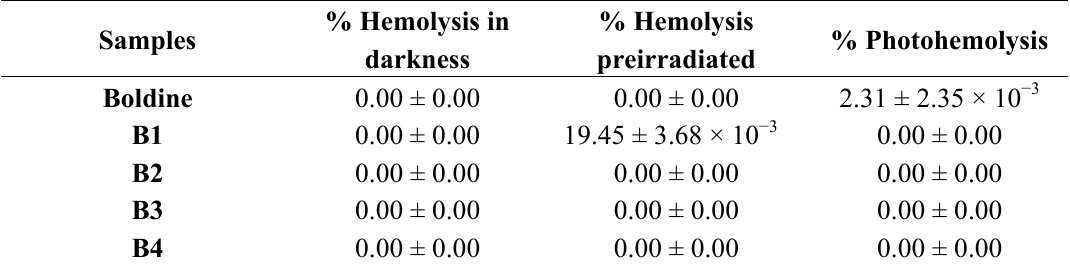
Table 2. Hemolysis and photohemolysis (%) with preirradiated boldine hydrochloride and its derivatives through red blood cell model.